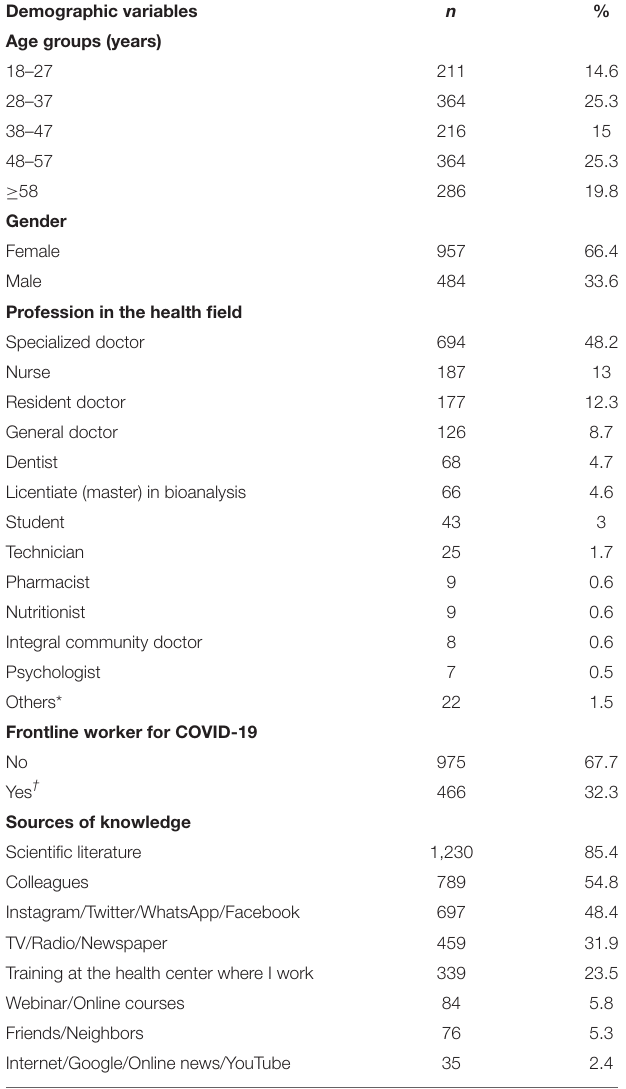
TABLE 1 | Healthcare workers’ socio-demographic characteristics and source of knowledge ( n =